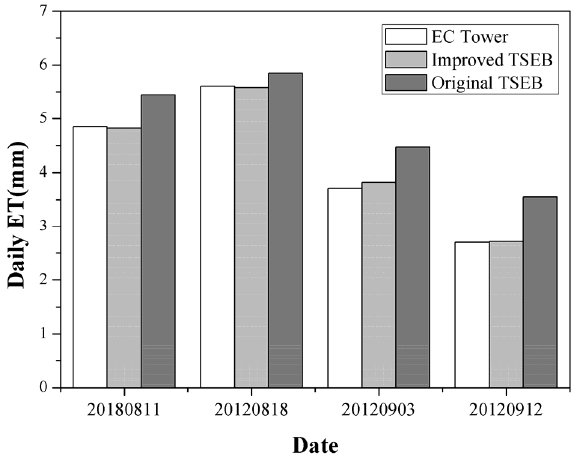
Figure 9. Maps of the daily ET from ASTER images for four days: 11 August, 18 August, 3 September, and 12 September.